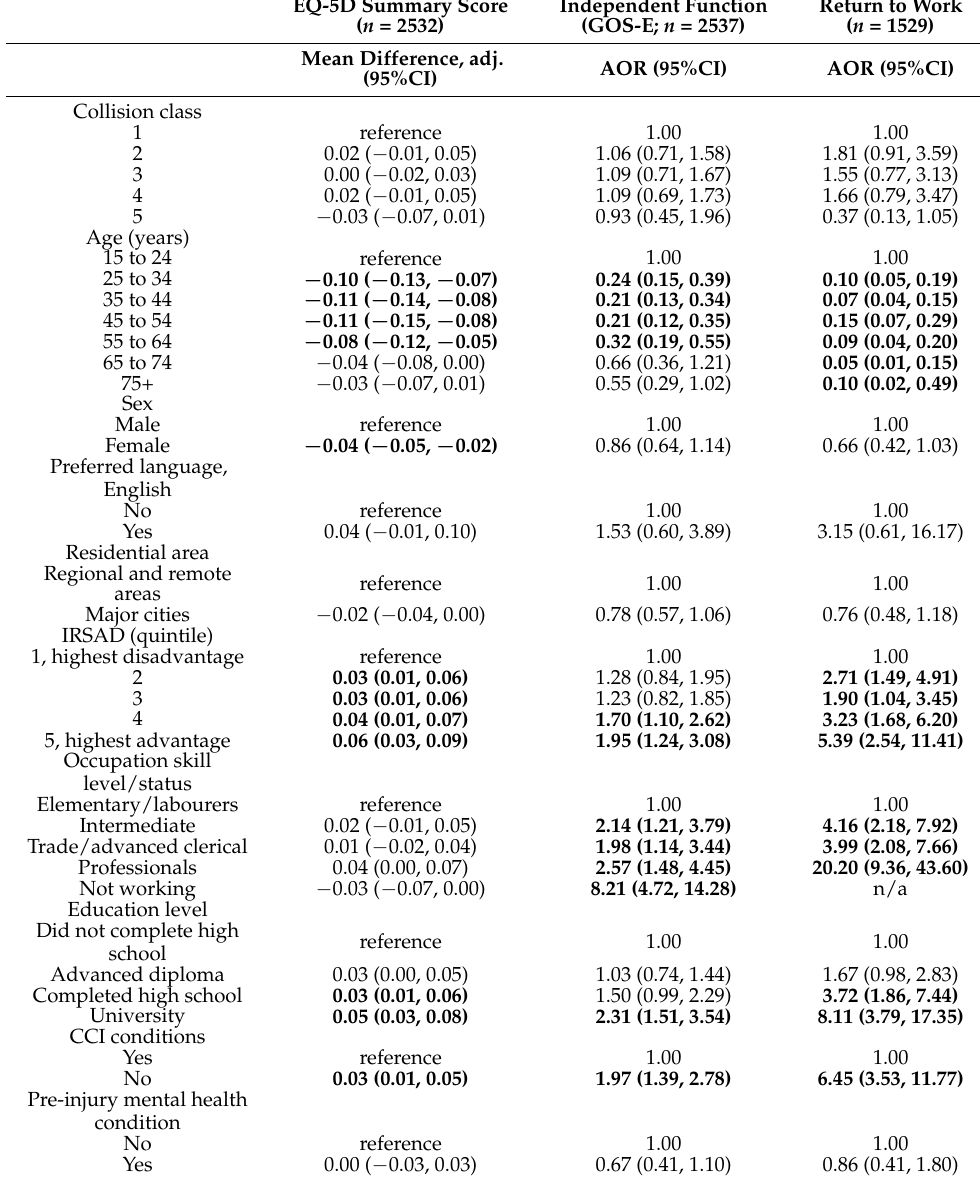
Table 3. Association between motor vehicle collision classes and health, functional and work out- comes, adjusting for all